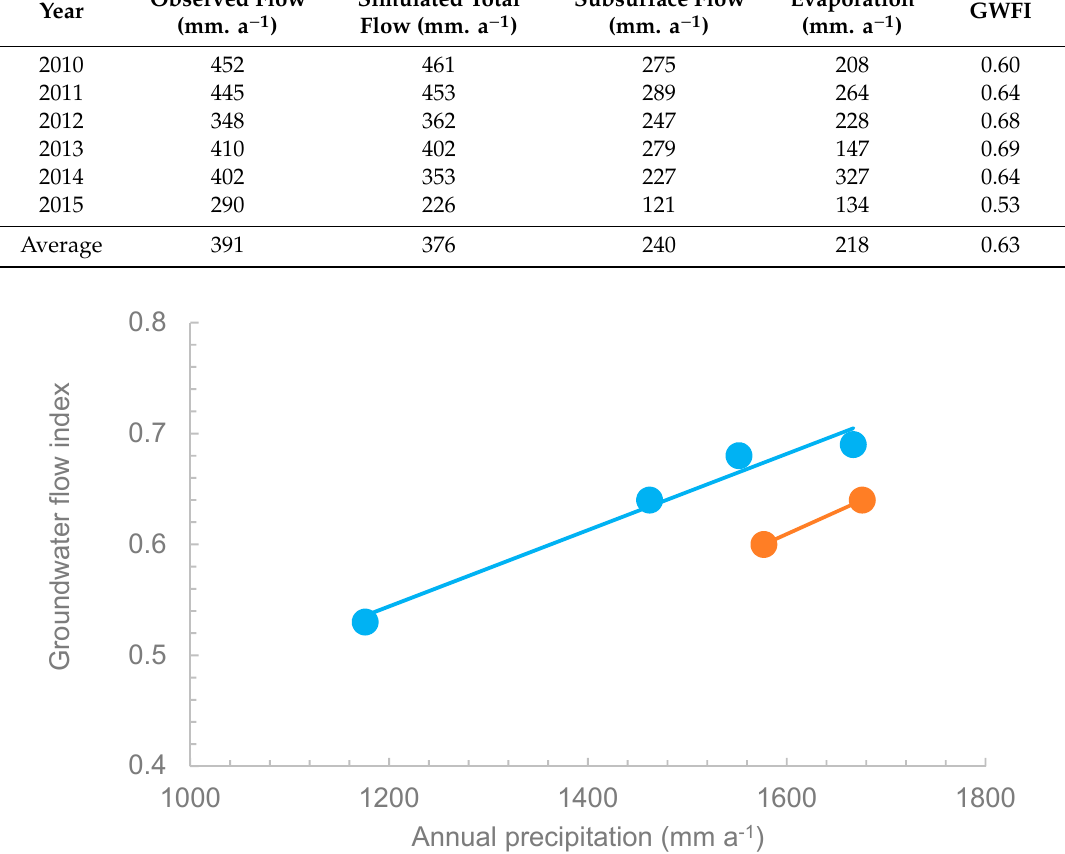
Figure 6. Groundwater flow index (GWFI) versus the annual precipitation before (2010 and 2011) and after (2012–2015) the implementation of land management.